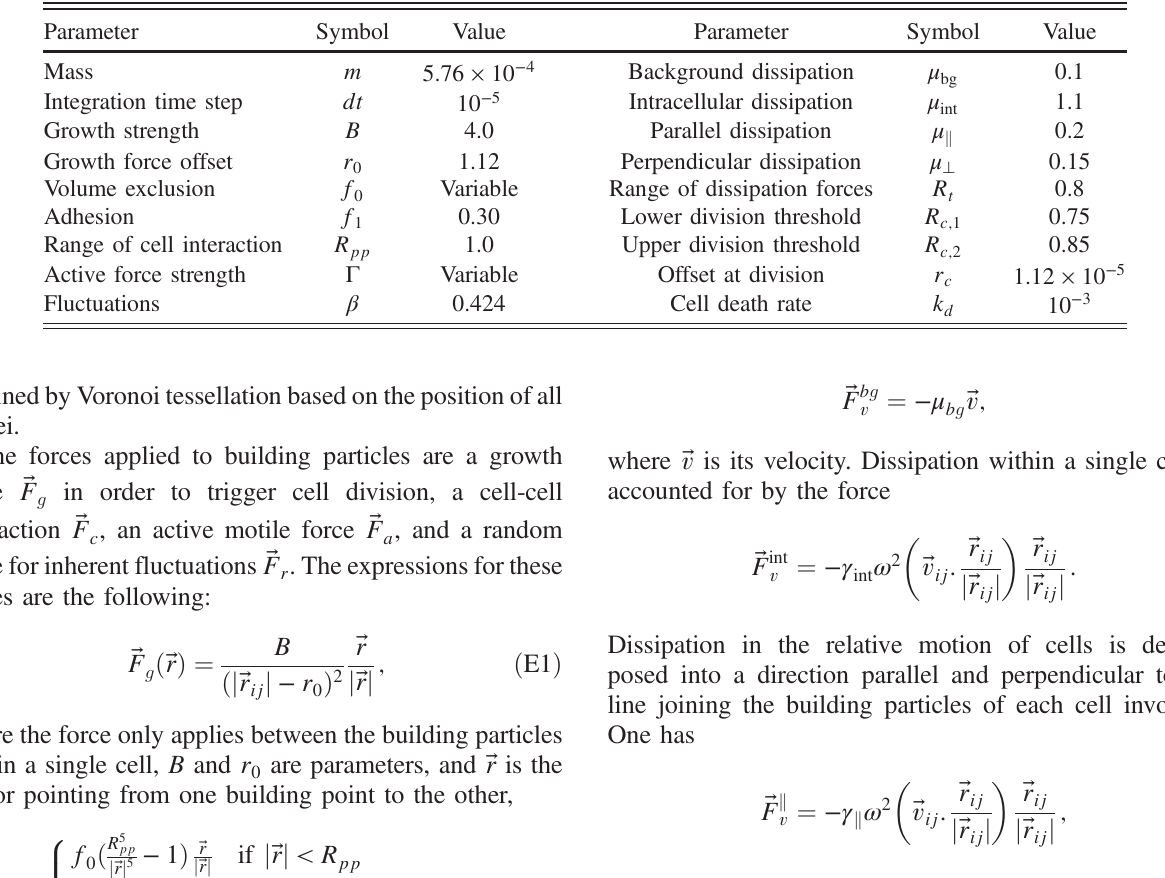
TABLE III. Parameters used in the simulation and expressed in simulation units (s.u.). The values of the parameters listed as “ variable ” change throughout the article.